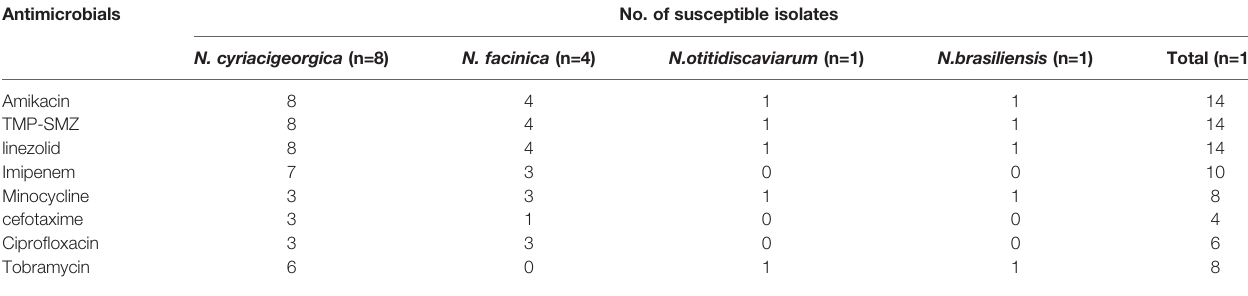
TABLE 2 | Antimicrobial susceptibility of Nocardia species was determined using the standard broth microdilution method.